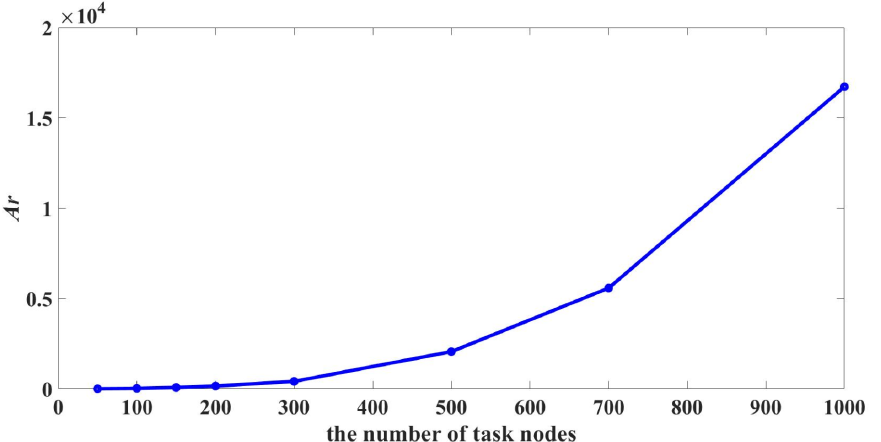
Figure 8. The values of Ar of the eight benchmarks.